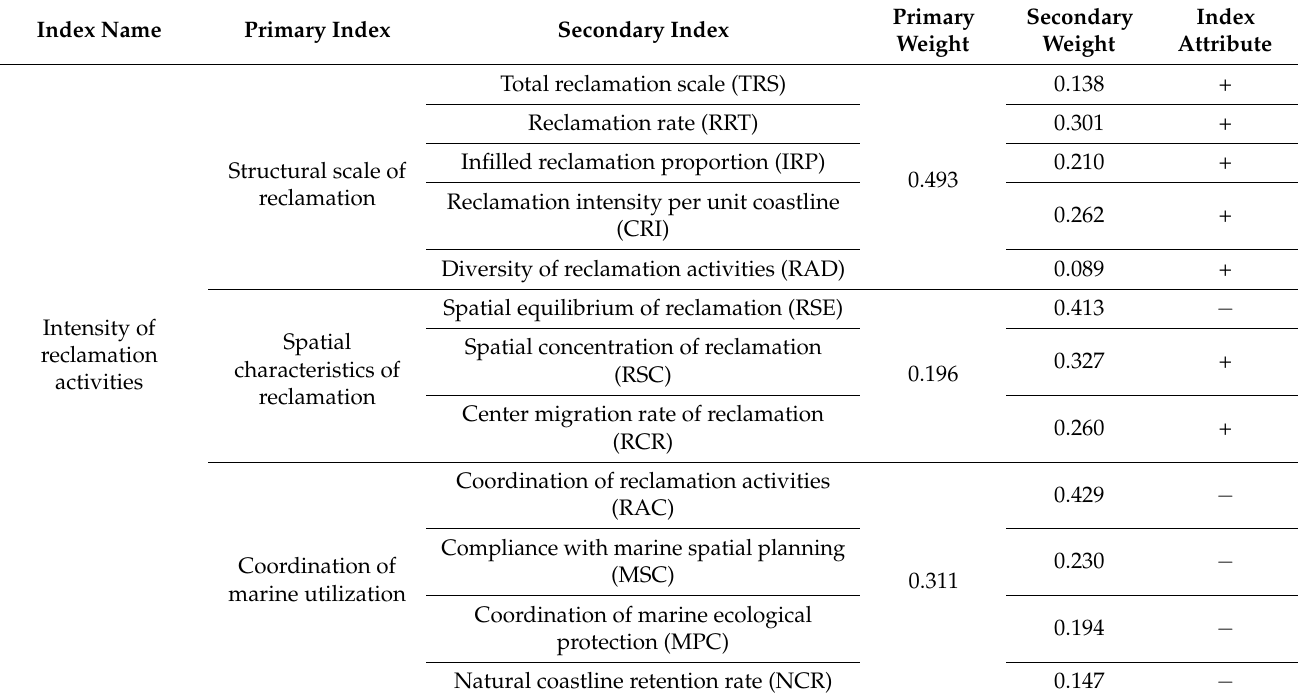
Table 2. Quantitative evaluation index system for reclamation intensity and index